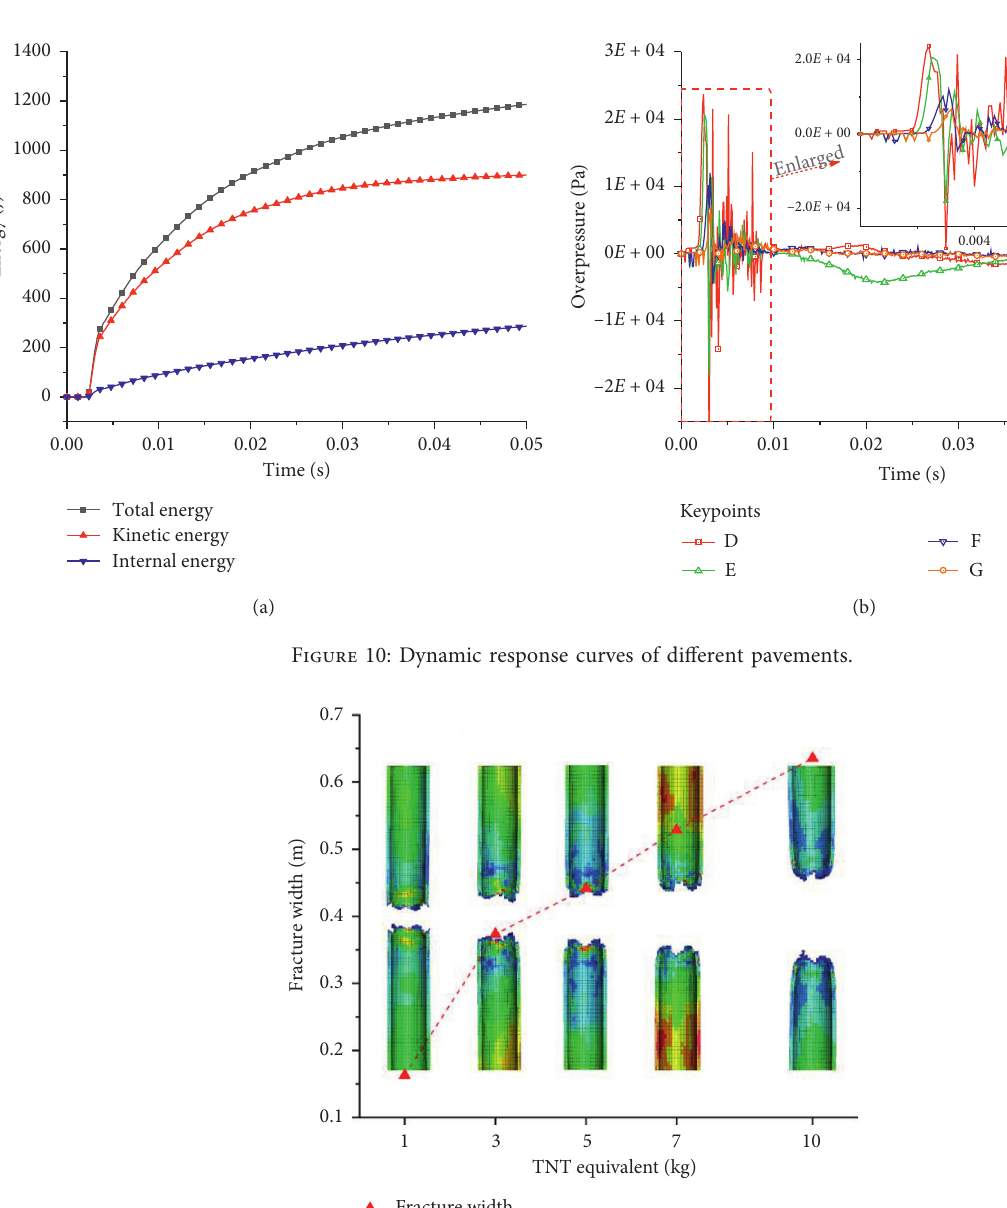
Figure 9: Deformation and strain distribution of pavements.